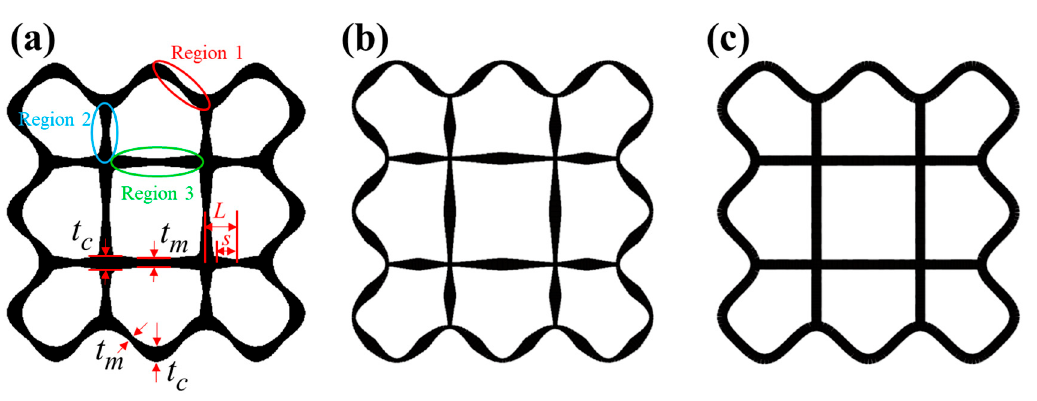
Figure 2. Three different cross sections of the MCCT: ( a ) decreasing thickness, ( b ) increasing thickness and ( c ) uniform thickness.